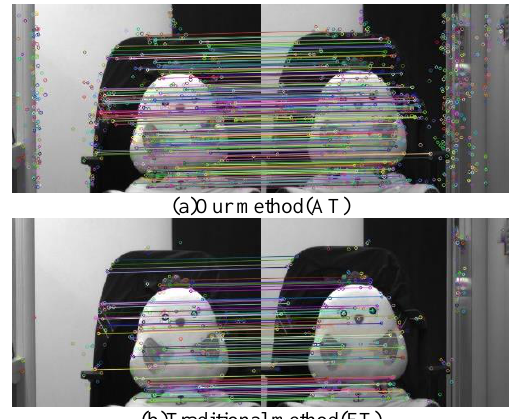
Fig. 8 The matching result using four strategies. Fig. 7 The comparison between using the AT and the smaller FT. (a) Matching result with AT = 0. 734 , the number of matching points is 212 and the correctly matching rate is 78.24%. (b) Matching result with FT =0.6, the number of matching points is 172 and the correctly matching rate is 71.9%.